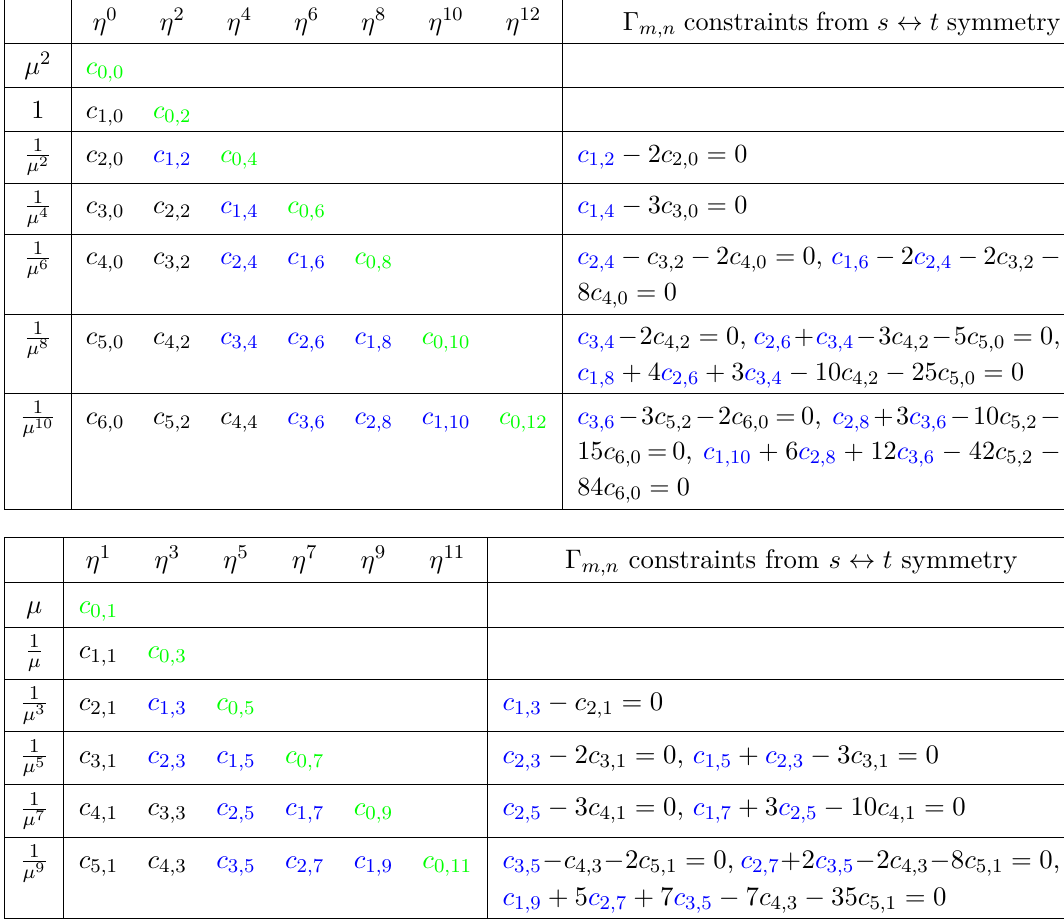
Table 1 . First constraints on s ↔ u symmetric coefficients c m,n from triple crossing symmetry. The label η n and 1 /µ 2 m + n − 2 can be understoon from eq. (5.40). The green c come from the m,n b ( t ) term in eq. (5.5), which can be fixed by the s ↔ t symmetry: c 0 , 2 k = c k, 0 and c 0 , 2 k +1 = 0 . The black ones can be chosen as the independent set of c with the full triple crossing symmetry. m,n We have preferred less t derivative coefficients because they are simpler. The blue ones can be 1 /µ 10 and further constraints at least up to order 1 /µ 22 can be obtained by eq. (5.40), eq.